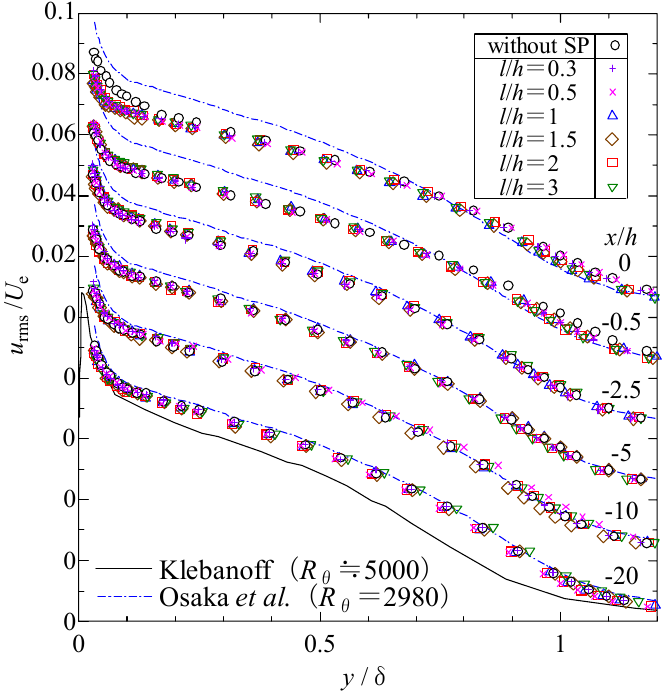
Fig. 2 Streamwise turbulent intensity